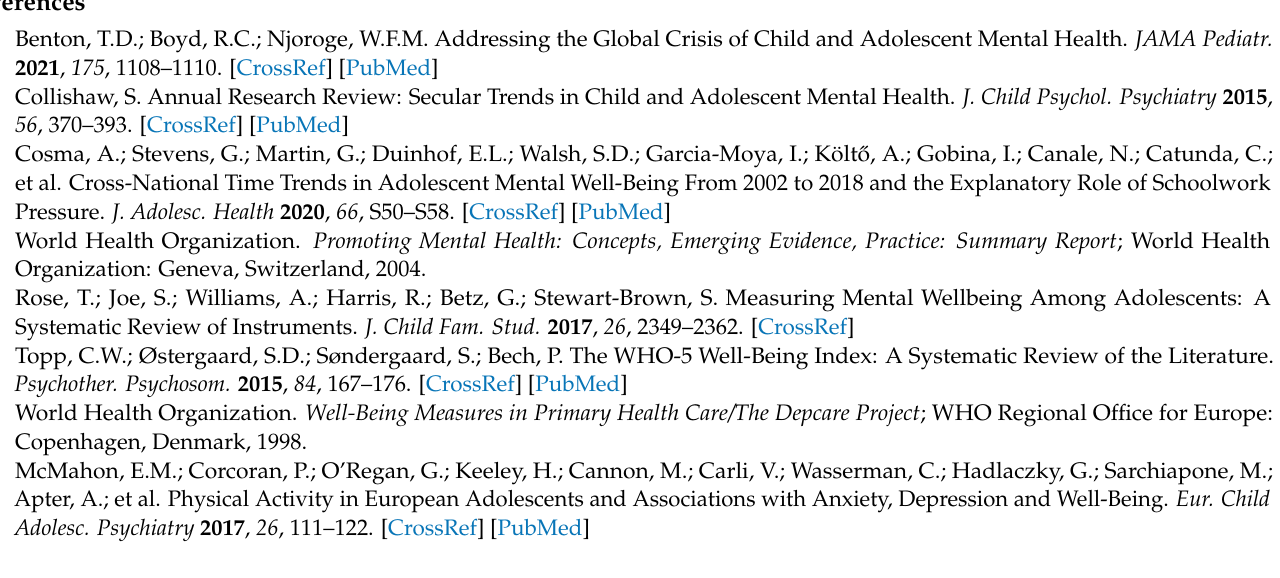
Table CFA model fit and reliability, by country ( N = 79,104, 15 countries); Table S2. WHO-4 Well-being Index, Table CFA model fit and reliability, by country ( N = 74,071, 15 countries); Table S3. Convergent validity: correlation coefficients using aggregated data (WHO-5) ( N = 74,071); Table S4.